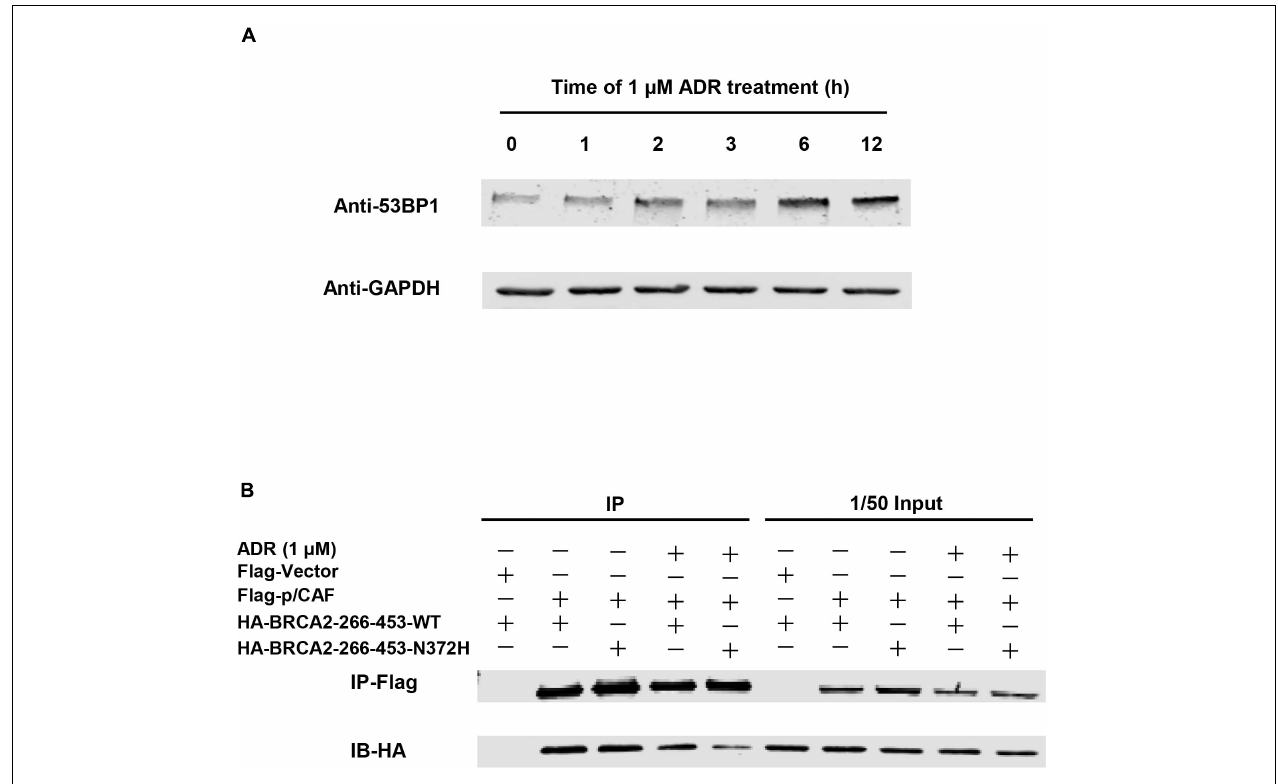
FIGURE 5 | Co-IP between BRCA2 and P/CAF. (A) The optimum concentration and time of treatment with ADR in SH-SY5Y to induce DNA double-strand breaks. 1 µ M ADR treated with 6 h could induce the expression of 53 bp1 enhanced significantly. (B) Co-IP showed that BRCA2-N372H substitution reduced the interaction between BRCA2 and P/CAF with the treatment of ADR (1 µ M and 6 h). SH-SY5Y cells were transfected with plasmids expressing Flag-p/CAF and HA-BRCA2-266-453-WT or HA-BRCA2-266-453-N372H and analyzed by co-IP with or without ADR treatment. Immunoprecipitates were analyzed by western blot with antibodies against Flag or